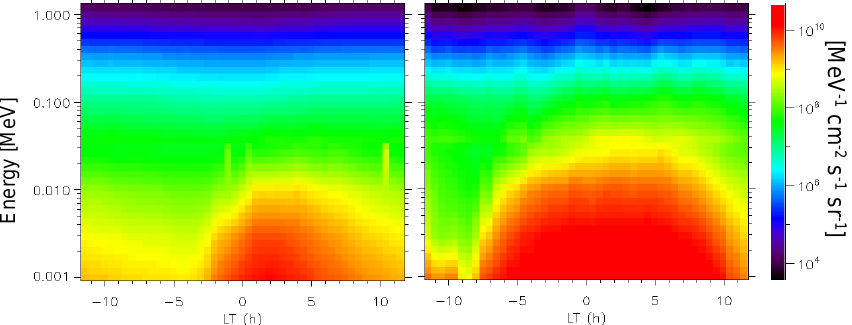
Fig. 7. Average electron flux at geostationary orbit in term of energy and local time map for two magnetic activity index (left, Kp=1 and right, Kp=6).